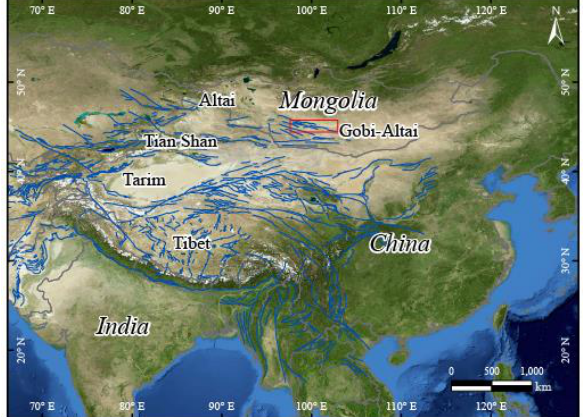
Figure 1. Main tectonic structures in Asia (blue lines). Red rectangular is the study area Gobi-Altai fault.